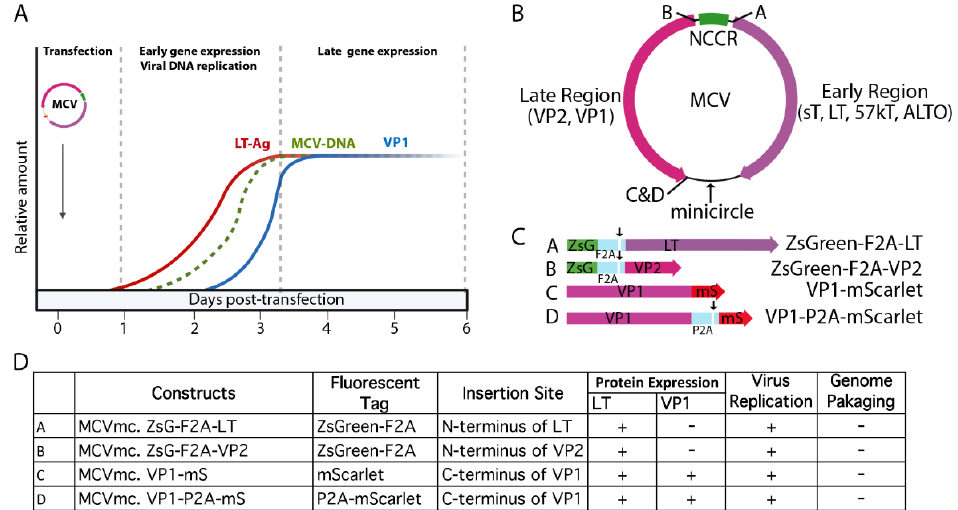
Figure 8. Kinetics of MCVmc reporter viruses. ( A ) A model of MCV replication kinetics, early/late gene expression as well as viral DNA replication is depicted. LT-Ag and VP1 expression kinetics is based on the Western blots in Figure 5. The MCV genome replication kinetics is hypothetical. ( B ) A map of MCVmcs with sites of fluorescent protein cassettes and minicircle vector insertion is indicated. ( C ) A detailed schematic of fluorescent-tagged MCV viral proteins that can be expressed from ( A ). Arrows in ( B ) indicate ribosome-skipping sites for F2A and P2A peptide sequences. ( D ) A table of tested MCVmc fluorescent reporter genomes. +: detected in transfected cells; – : not detected in transfected cells.